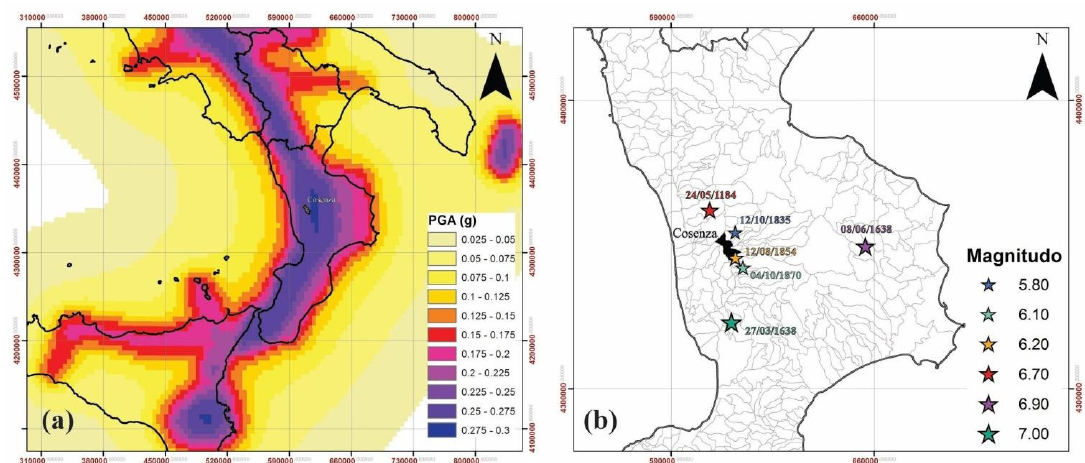
Figure 1. ( a ) Map of the peak ground acceleration values (PGA, g) with 10% probability of being exceeded in 50 years (modified by [15]). ( b ) Map of the epicenters referred to the historical earthquakes, which produced damage to the built-up area of Cosenza.